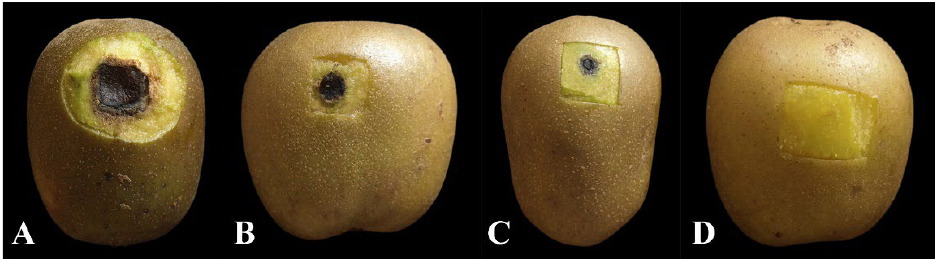
Table 3. Control efficacy of different concentrations of SS on kiwifruit black spot. Treatment Lesion Diameter (mm) Control Efficacy (%) Control 20.62 ± 0.66 a - 100 mL L − 1 0 ± 0 d 100 ± 0 a Numerical values were expressed as mean ± SE of triplicates. Different lowercase letters represent a significant difference of the same columns ( p < 0.05, n = 3).